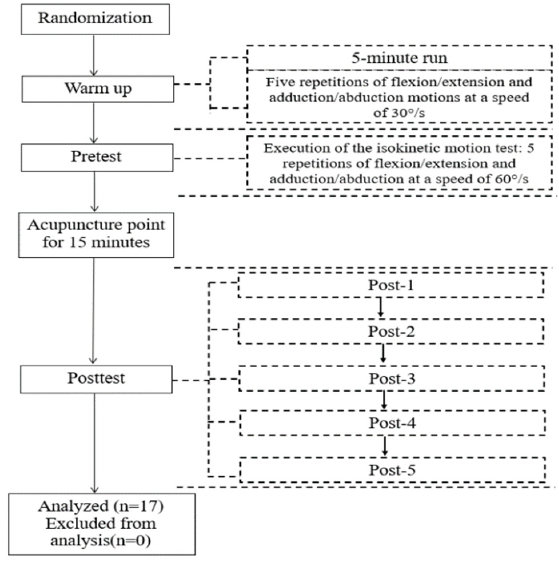
Figure 3. Experimental